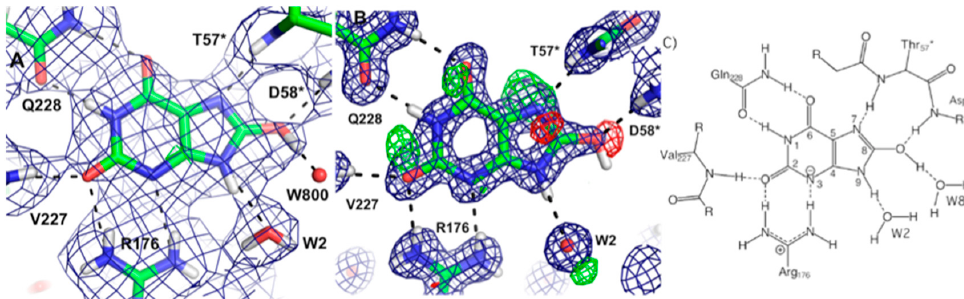
Figure 11. The 2.35 Å resolution 2mF o -DF c nuclear density map of urate oxidase ( A ) compared with the 1.05 Å X-ray map ( B ); ( C ) a schematic representation of the surroundings of the urate substrate. Panels A and B reproduced from [42].